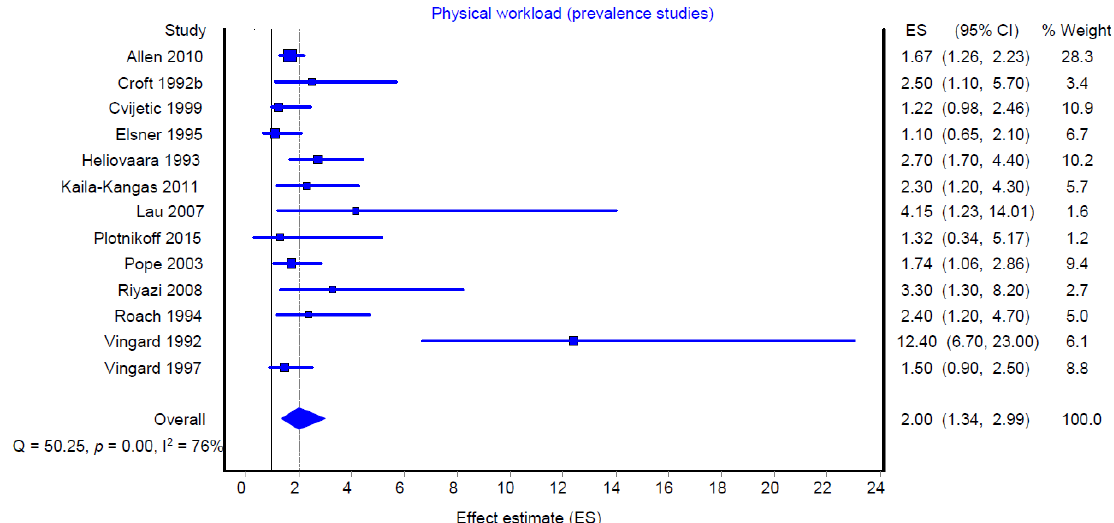
Figure 2. Meta-analysis of heavy physical workload/heavy lifting and the risk of hip osteoarthritis (all prevalence studies, n = 13).